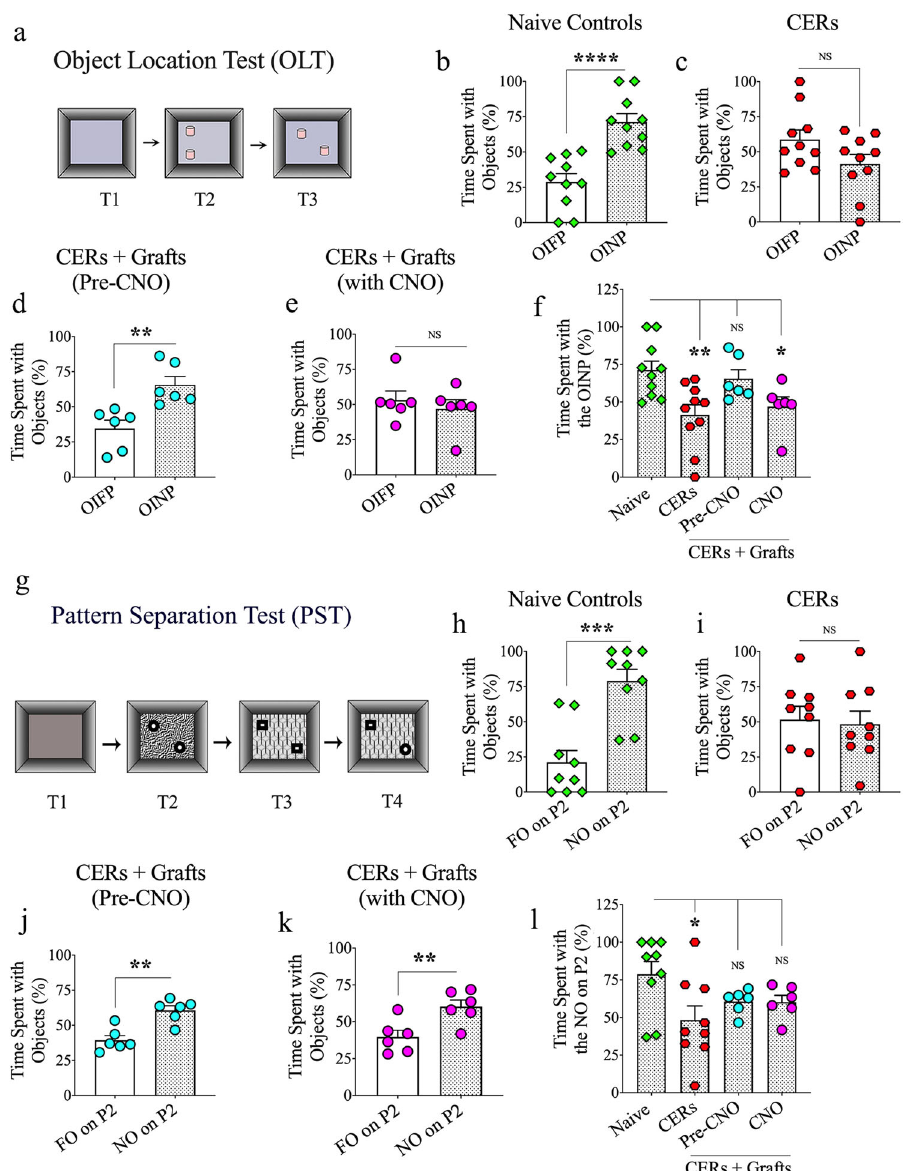
Fig. 5 Effects of grafting human medial ganglionic eminence (hMGE) progenitor cells expressing the Gi-protein-coupled receptor hM4Di into the hippocampus of chronically epileptic rats (CERs) on cognitive function. a depicts the various trials involved in an object location test (OLT). The bar charts in b – e compare percentages of time spent with the object in the familiar place (OIFP) and the object in the novel place (OINP) in naive control rats ( b ), chronically epileptic rats (CERs; c ), and CERs with hMGE grafts before and during the clozapine-N-oxide (CNO) treatment ( d , e ). The bar chart in f compares the time spent with the OINP across the four groups with ANOVA. Object location memory was impaired in CERs with no grafts and CERs with grafts when graft-derived interneurons were silenced. g shows the various trials involved in a pattern separation test (PST). The bar charts in h – k compare percentages of time spent with the familiar object on pattern 2 (FO on P2) and the novel object on pattern 2 (NO on P2) in naive control rats ( h ), CERs ( i ), and CERs with hMGE grafts before and during the clozapine-N-oxide CNO treatment ( j , k ). The bar chart in l compares the time spent with the NO on P2 across the four groups with ANOVA. Note that pattern separation ability was impaired in CERs with no grafts. However, CERs with grafts displayed pattern separation ability even when the graft- derived interneurons were silenced with CNO. Values in bar charts are presented as mean ± S.E.M. * p < 0.05, ** p < 0.01, *** p < 0.001, **** p < 0.0001, NS, non-signi fi cant ( b – e , h – k , unpaired, two-tailed Student ’ s t test; f , l , one-way ANOVA with Newman – Keuls multiple comparisons Furthermore, the parameters such as total object exploration transplant-derived DREADDs expressing interneurons through times, distances traveled, or movement velocities were compar- CNO administration and performed the PST with new objects able between the pre-CNO and CNO periods (data not illustrated). and fl oor patterns. With the silencing of transplant-derived Comparison of the time spent with the NO on P2 across groups interneurons, CERs did not lose their ability to distinguish the (naive, CERs, CERs + grafts in the pre-CNO and CNO periods) using NO on P2 from the FO on P2, which was evident from their one-way ANOVA with the Newman-Keuls multiple comparison exploration of the NO on P2 for higher periods than FO on P2 tests revealed impaired pattern separation function in CERs with ( p < 0.01, unpaired, two-tailed Student ’ s t test, Fig. 5k).